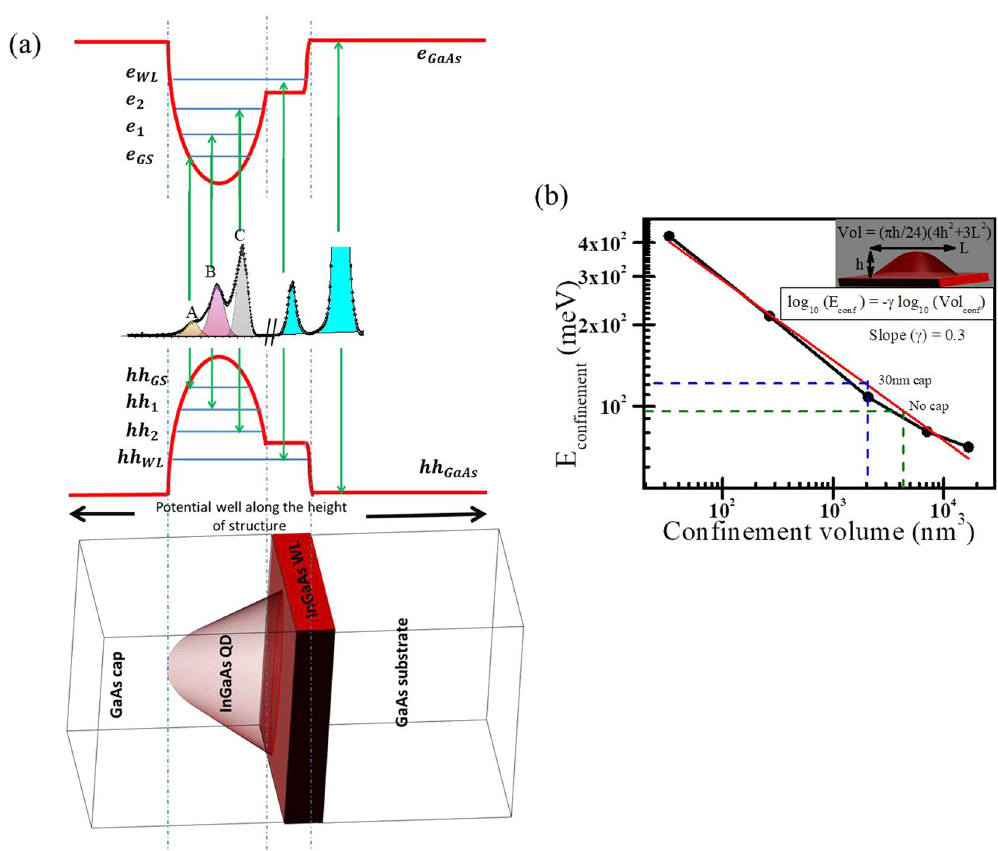
Figure 5. ( a ) Correlation between structure of QDs and obtained PL lines are linked by the excitonic level formation inside the QDs and WLs. Different PL lines (for 5 nm GaAs cap sample) has been associated with the composition and shape dependent exciton levels of QDs. ( b ) The variation of confinement energy with respect to the confined volume for lens shape InGaAs quantum dots. Black dots are the obtained values of electron ground state energy and heavy hole ground state energy 34 . Red line is the least square fitting of the data points which shows slope of 0.3. Blue line and green line indicate the confinement energy values for confinement volume nm 2049 3 and 4080 nm 3 of lens shaped QDs for 30 nm capped and uncapped sample in GID